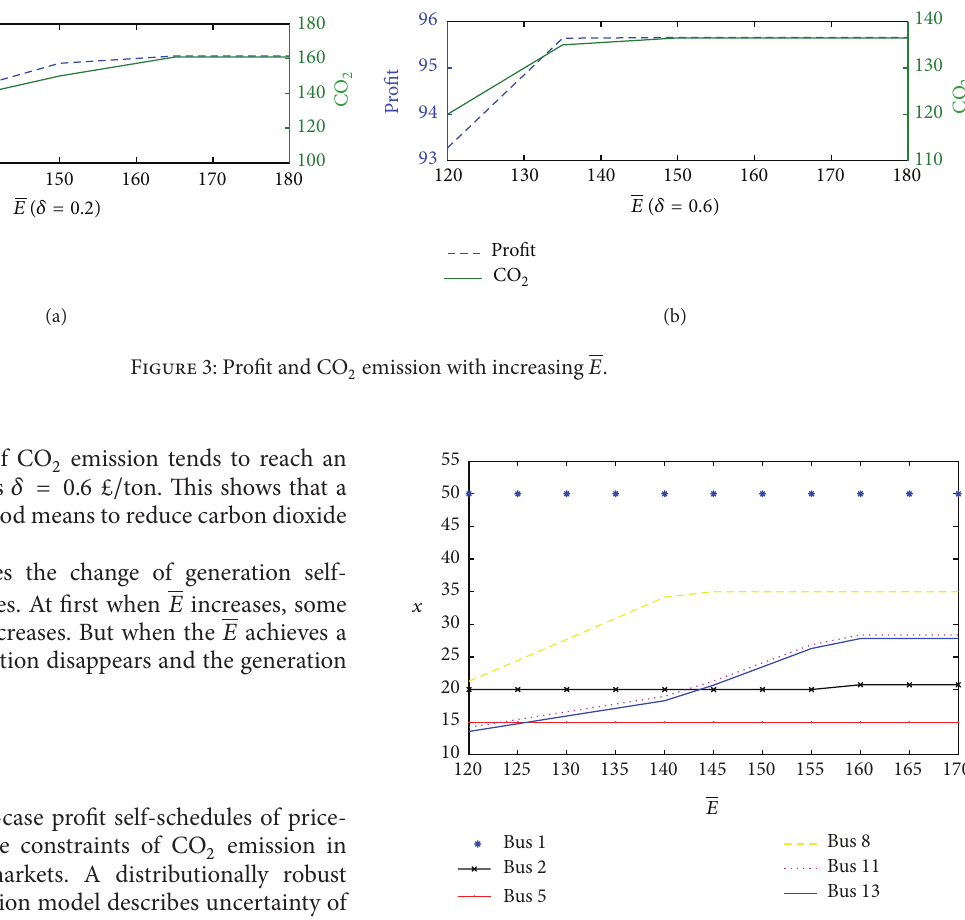
Figure 4: Generation self-schedule 𝑥 with increasing 𝐸 .